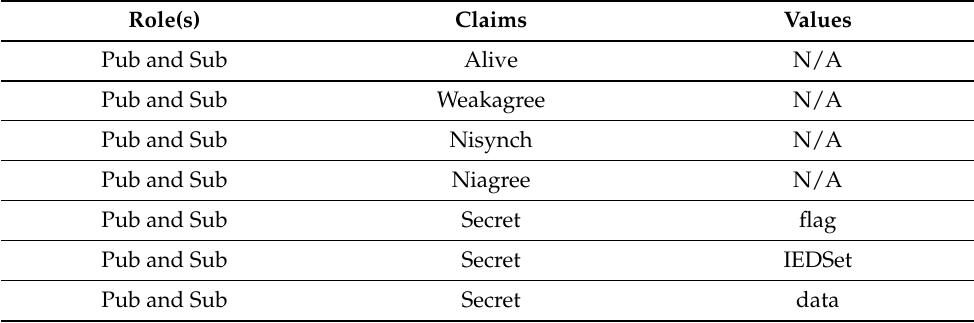
Table 5. Security claims for the GOOSE protocol’s communication.